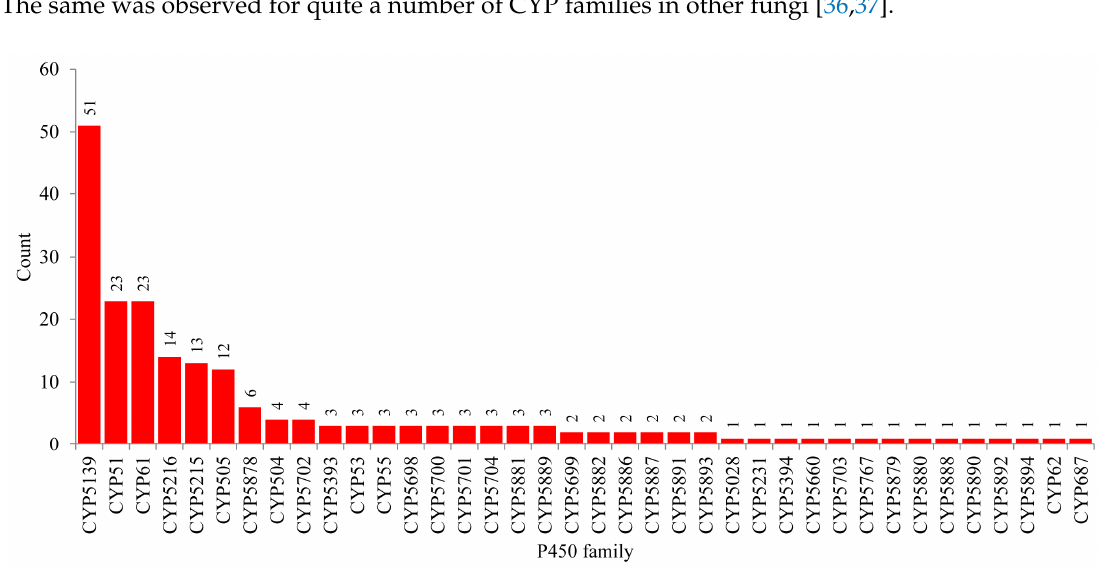
Figure 3. The CYP family-level comparative analysis in the species of Tremellomycetes . The numbers next to the family bar indicate the total number of CYPs. The data on the number of CYPs in each CYP family, along with subfamilies, are presented in Supplementary Dataset 2, sheet 1.